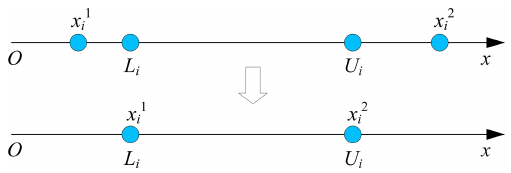
Figure 5. Schematic diagram of the variables repairing